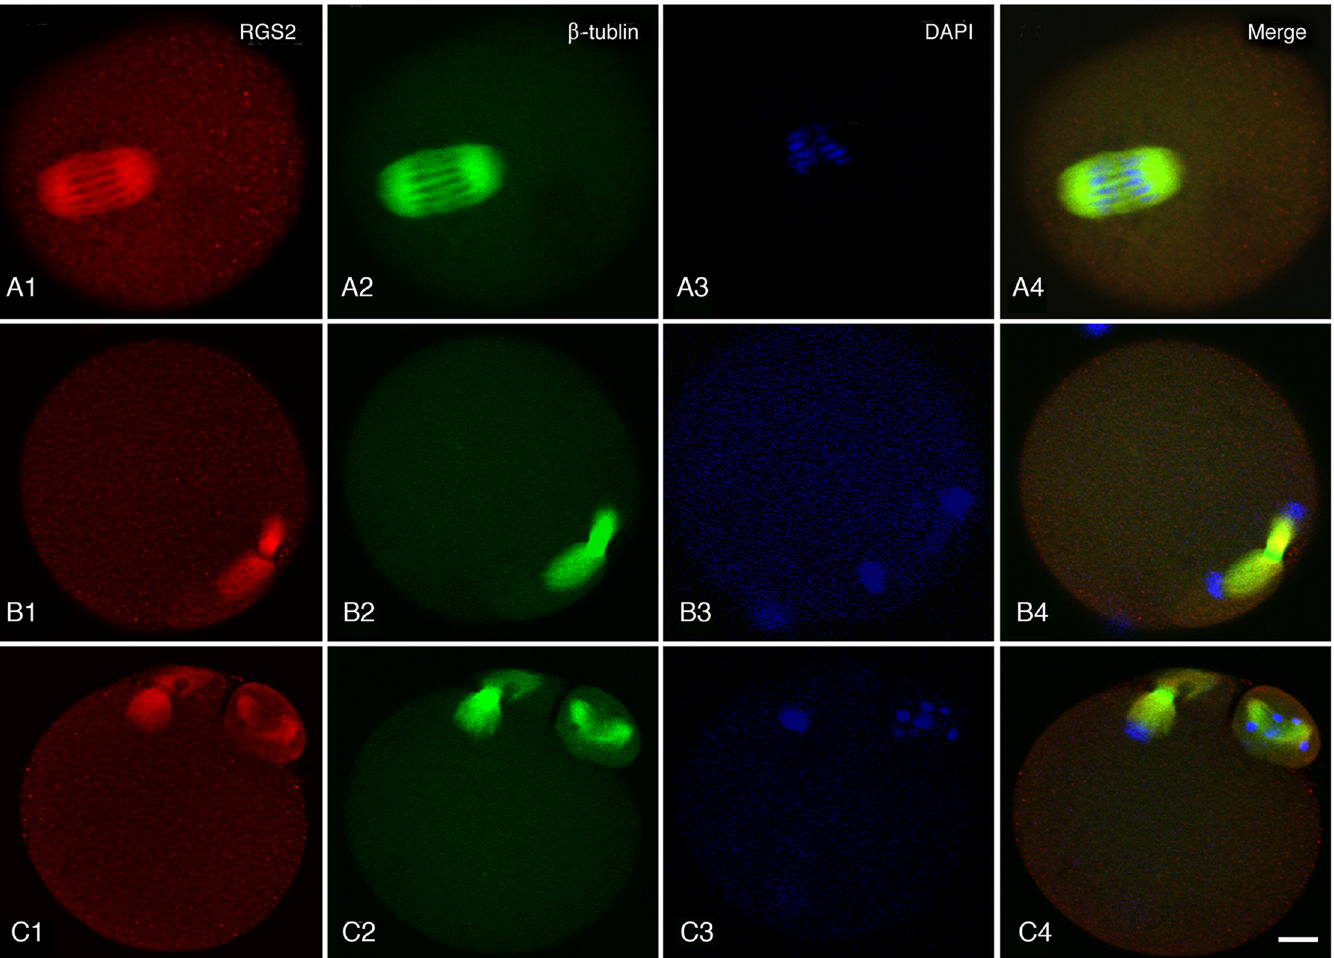
Fig 3. Co-localization of RGS2 and β -tubulin in the meiotic spindle. RGS2 and β -tubulin were co-expressed in spindles of metaphase oocytes (A), anaphase/telophase oocytes (B), and both in telophase oocytes and their polar bodies (C). RGS2 and β -tubulin co-localized on all meiotic spindles. The image shows staining for RGS2 in red, β -tubulin in green, and nuclei in blue. Scale bar, 20 μ